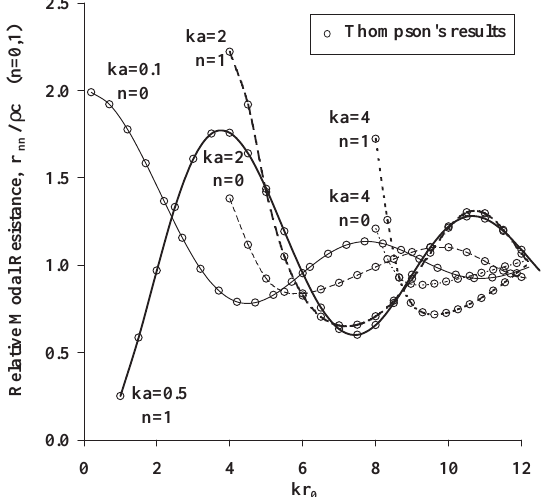
Fig. 10. Relative modal resistance components versus the separation parameter in the acoustic halfspace limit ( kr 0 = kd 1 orkd 2 , and d 2 = 100 a or d 1 = 100 a , respectively).